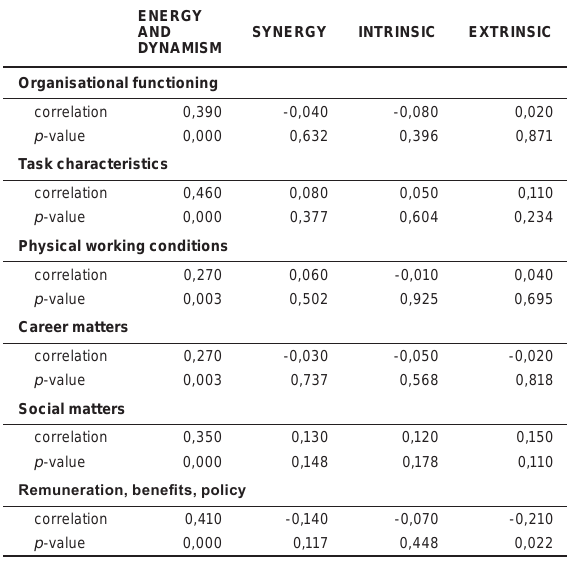
Table 2 Pearson correlations between the dimensions of the MQ and the scales of the